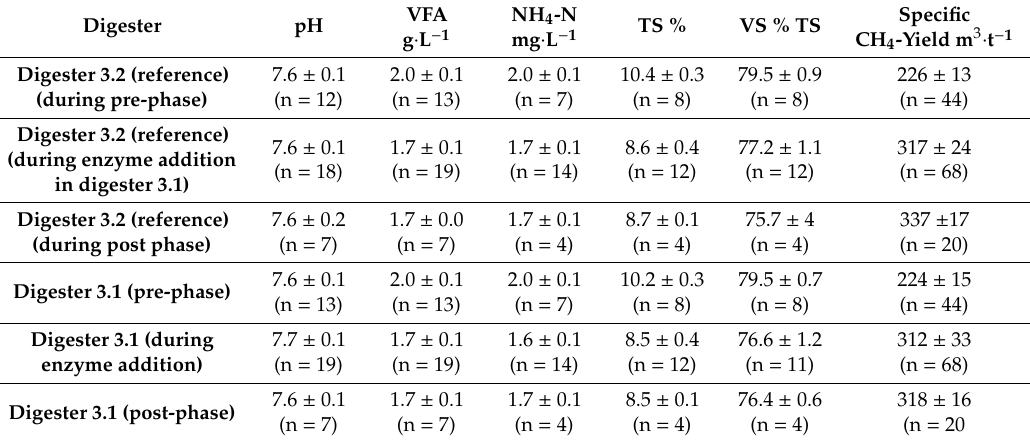
Table 2. Process parameters in digester 3.1 (enzyme addition) and 3.2 (reference) during di ff erent experimental